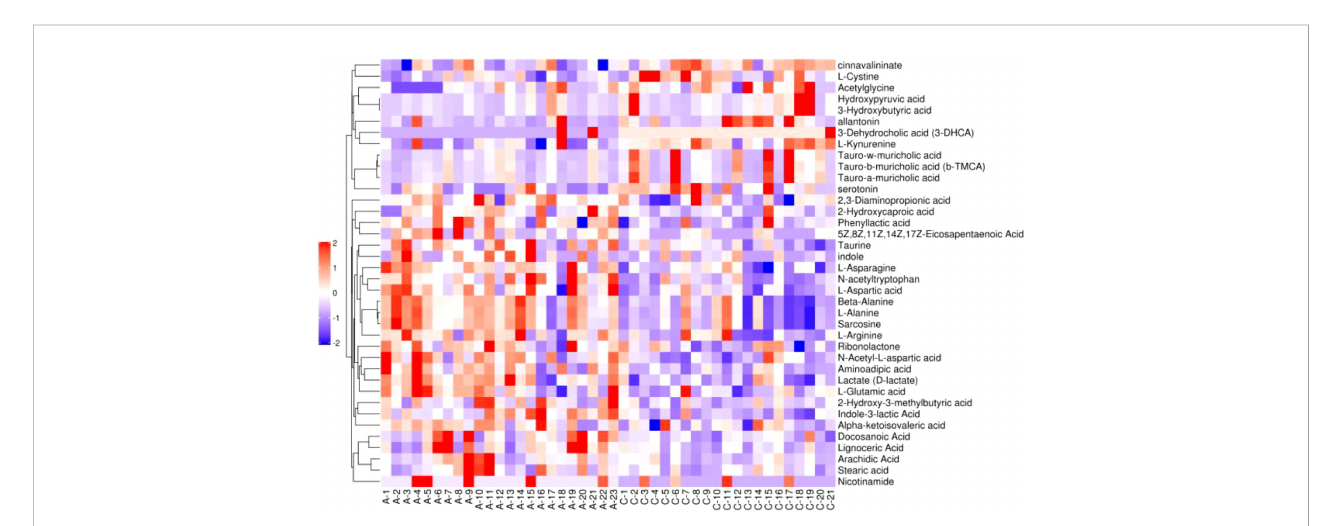
FIGURE 7 Heatmap of signi fi cant differential metabolite hierarchical clustering in treatment group versus normal control